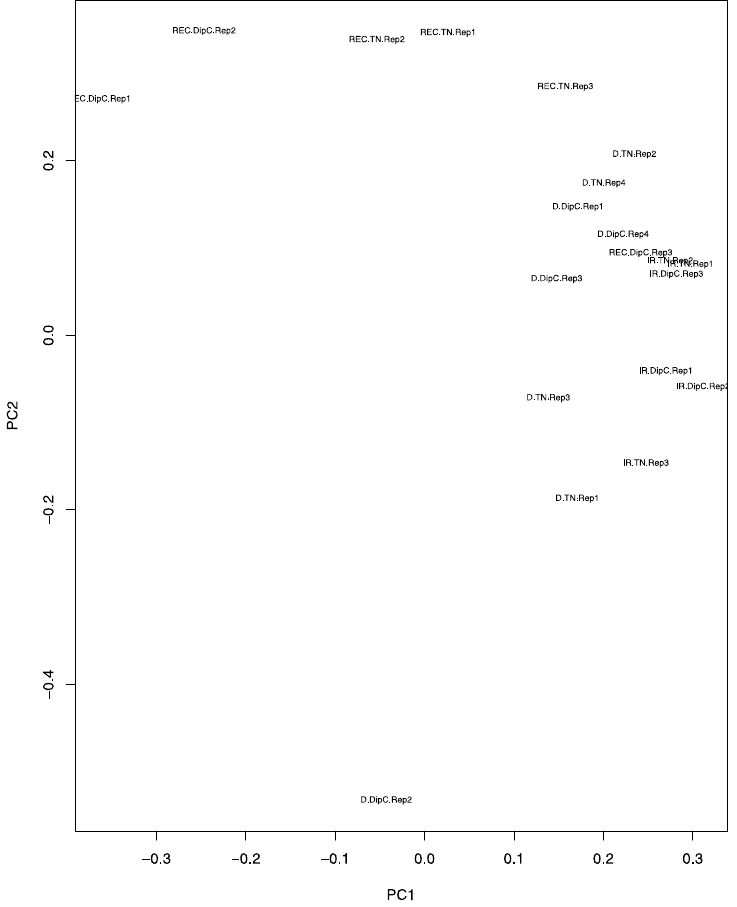
Figure 2. Principal component analysis (PCA) plot of the expression data from the microarrays. The principal components PC1 and PC2 values for each chip have been placed on a scatter plot. Each chip result is defined by a three-part character string consisting of the treatment, genotype, and replicate number. IR, D, and REC refer to water-sufficient, water-limited, and recovery treatment, respectively; the genotypes are DipC and TN; and Rep1–4 refers to the specific biological replicate. Note, the water- sufficient and recovery treatments have only three replicates, while dehydration has four.